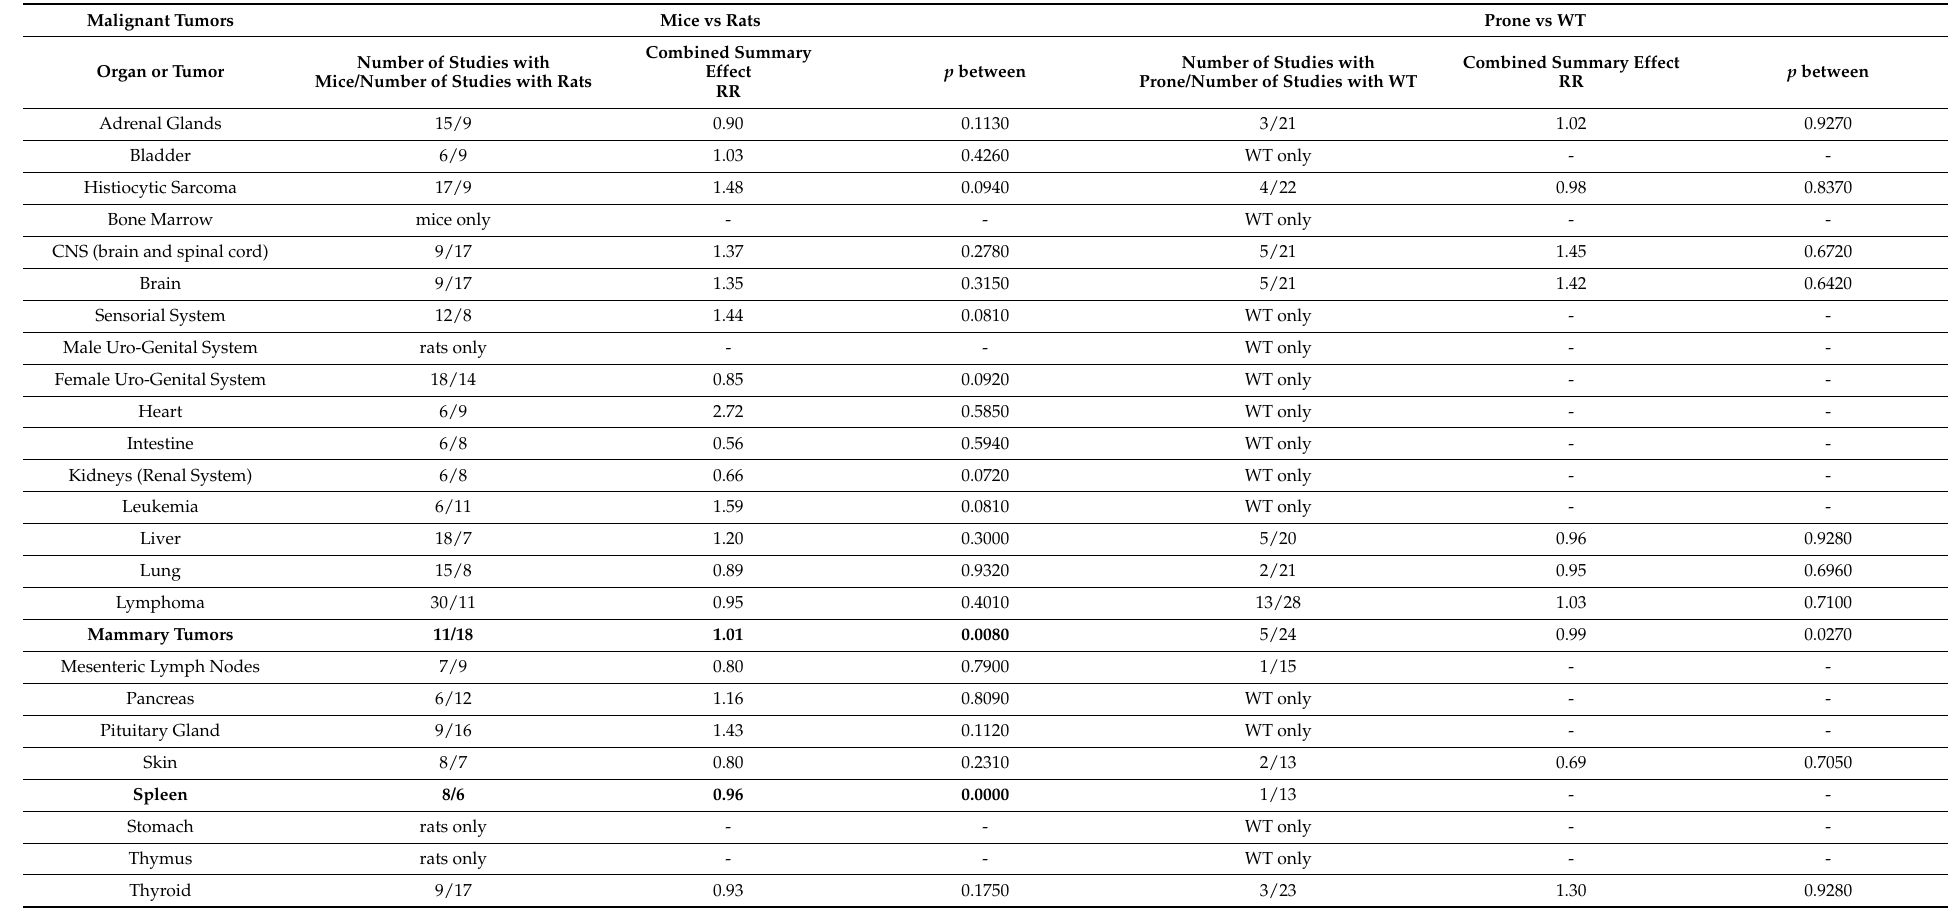
Table 6. Summary table of the subgroup analysis on malignant tumors: the selected covariates for relevance are the species (mice vs. rats) and the genetic background (prone vs. WT). Bold items represent the results with statistical